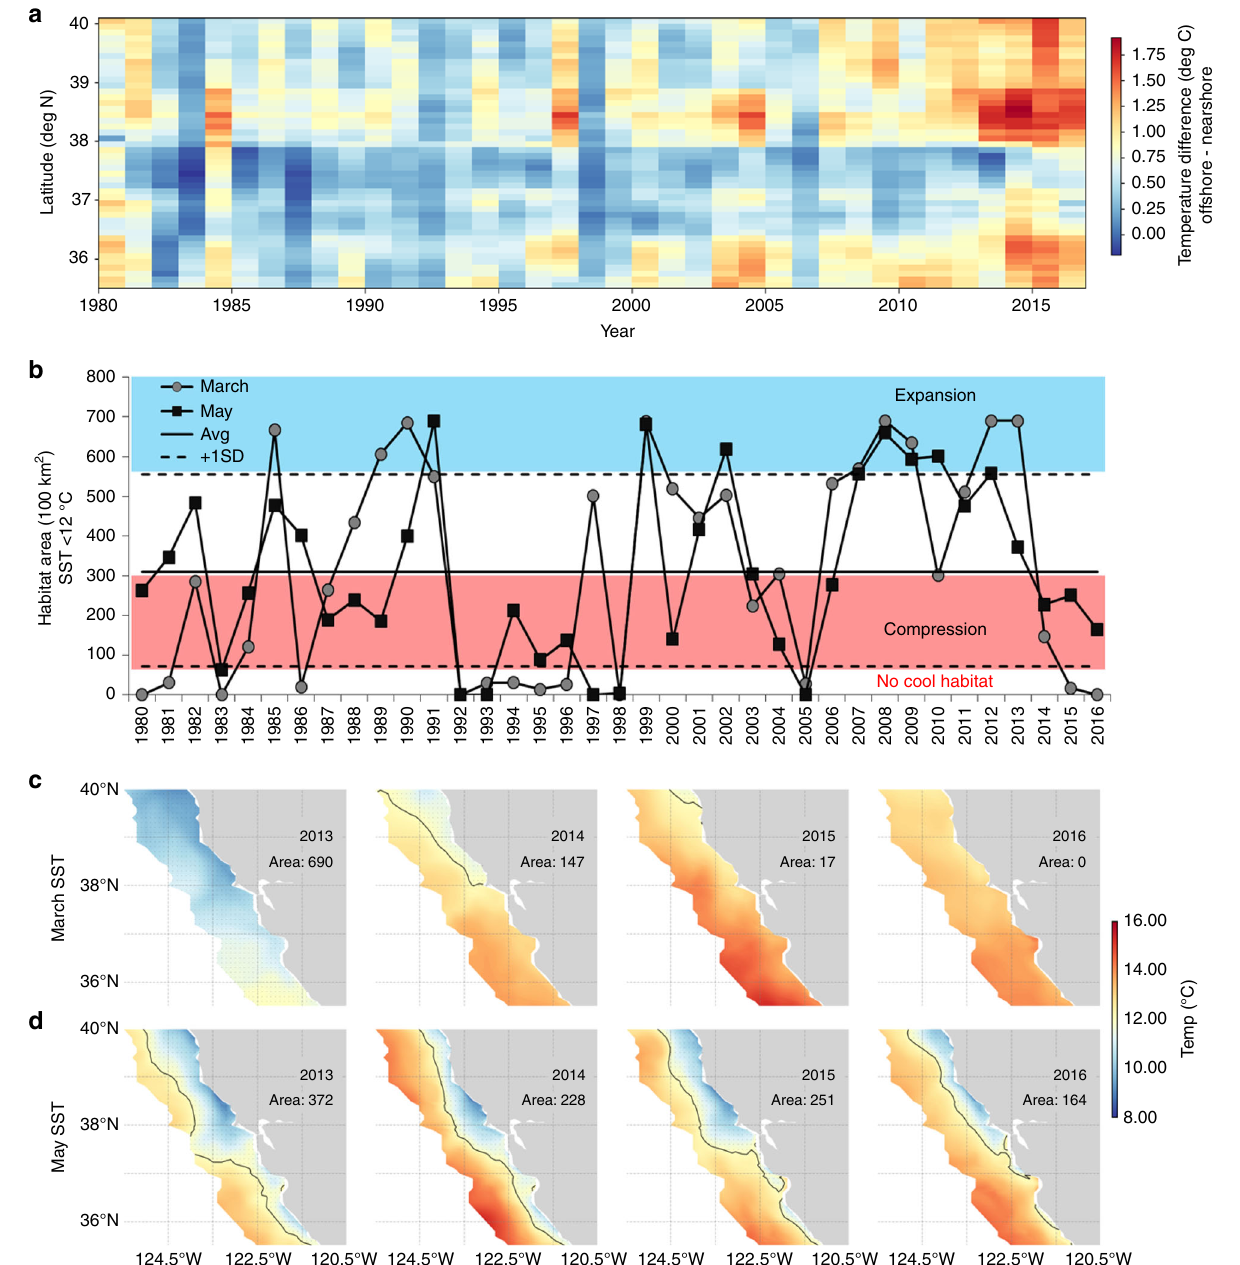
Fig. 1 Upwelling habitat compression index, 1980 – 2016 (2 m surface temperature, derived from data-assimilative oceanographic model). a difference in onshore (0 – 50 km) and offshore (51 – 150 km) temperature gradients (average of March – May) as a function of latitude off California ( b ) time series describing change in area of cool 12 °C water during early March and May; the long-term mean and standard deviation provides basis for assessing the relative amount of cool surface water habitat and likelihood of cool water expansion vs. habitat compression, where values above + 1 SD indicate enhanced cool ocean conditions (i.e., La Niña or strong upwelling) and below − 1 SD indicate no available cool habitat (e.g., El Niño or delayed upwelling); c , d spatial depiction of the change of cool water habitat during March and May during preceding (2013) and during (2014 – 2016) the marine heatwave and El Niño; the thin black line represents the 12 °C contour and area represents the number of pixels with values ≤ 12 °C. Source data are provided within the Source Data fi